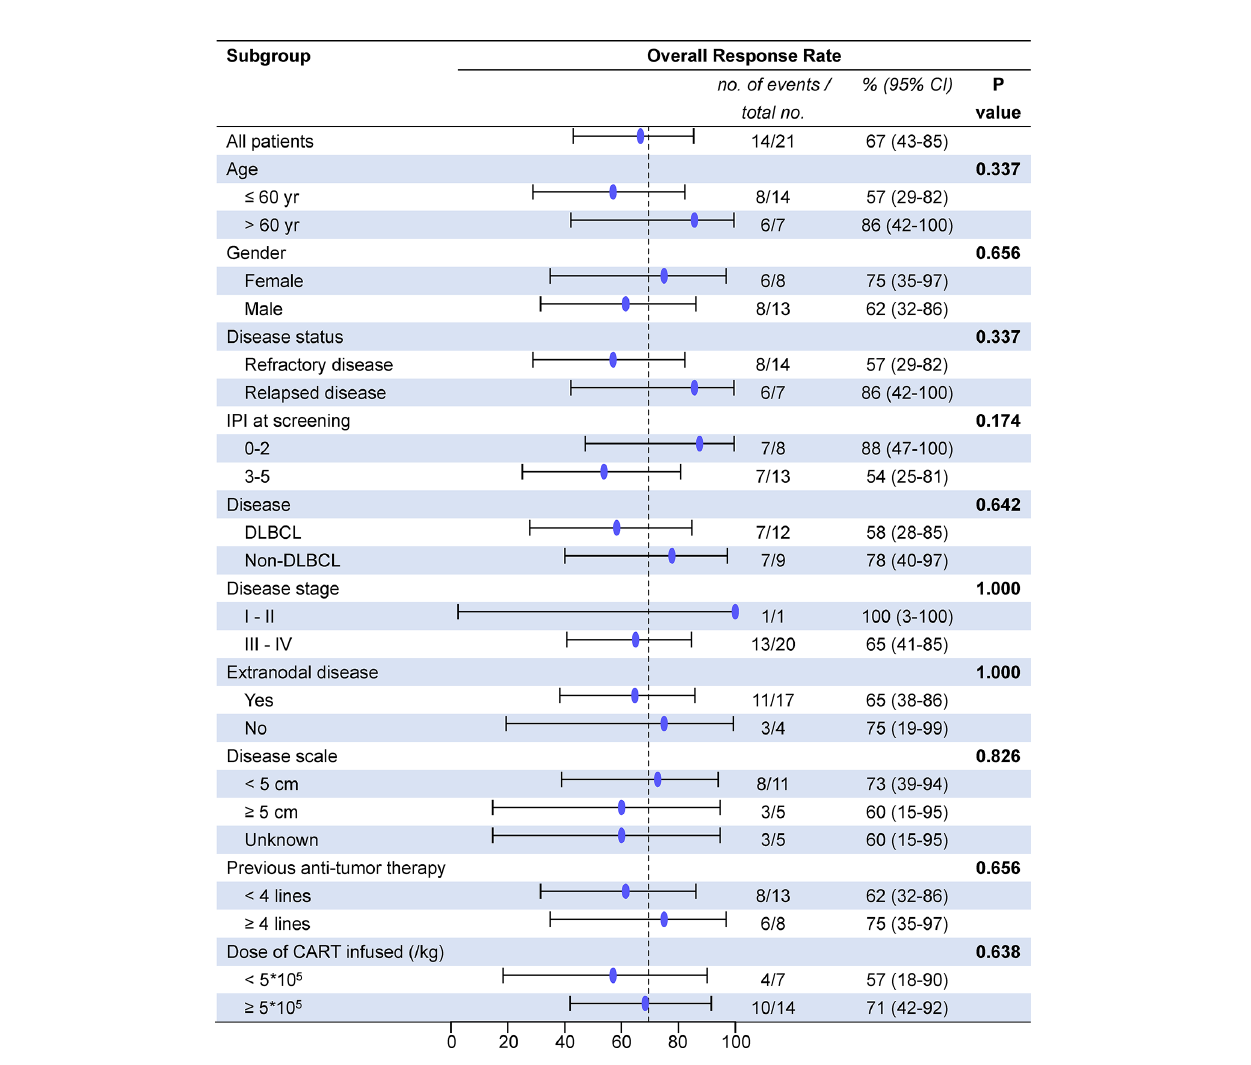
FIGURE 3 | Overall response rate between subgroups. DLBCL, diffuse large B cell lymphoma; IPI, International Prognostic Index; CAR-T cells, chimeric antigen receptor T cells; CI, con fi dence